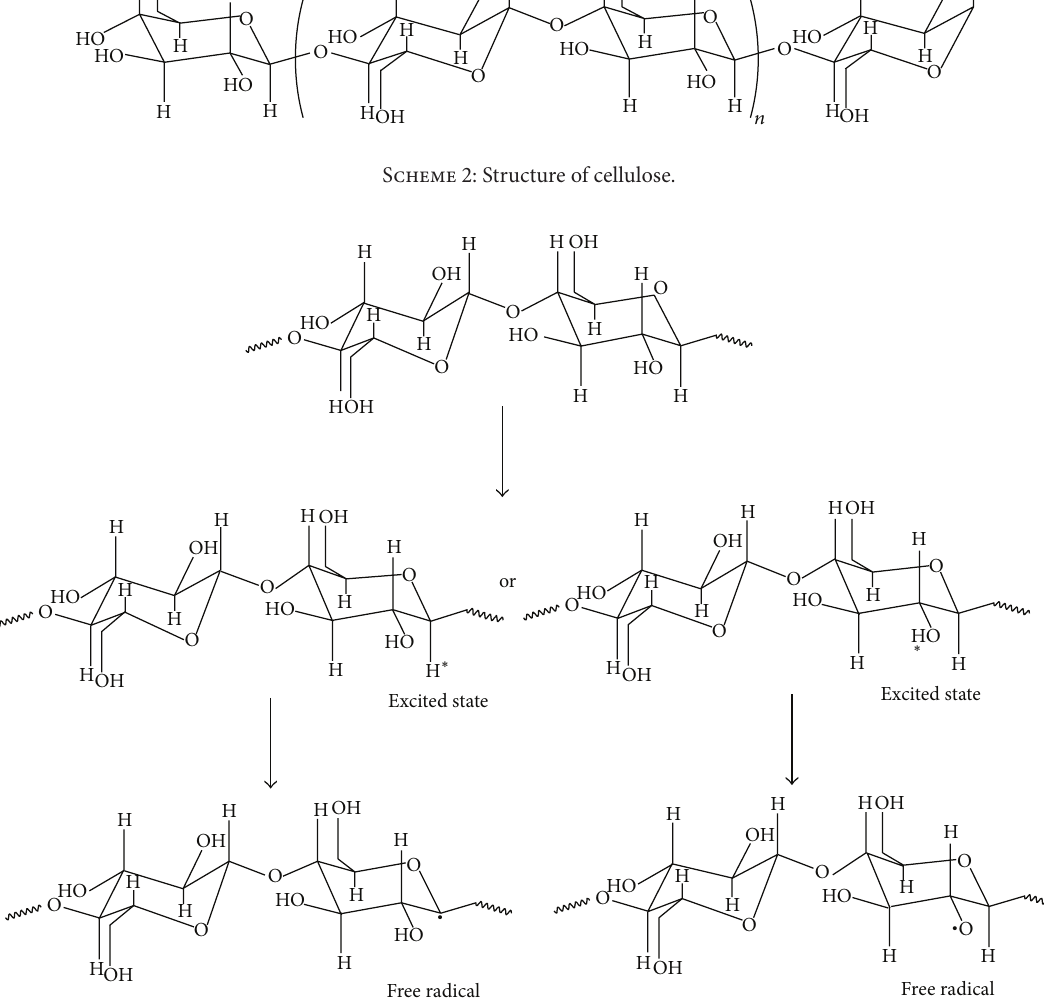
Scheme 3: Radical formation on the cellulose